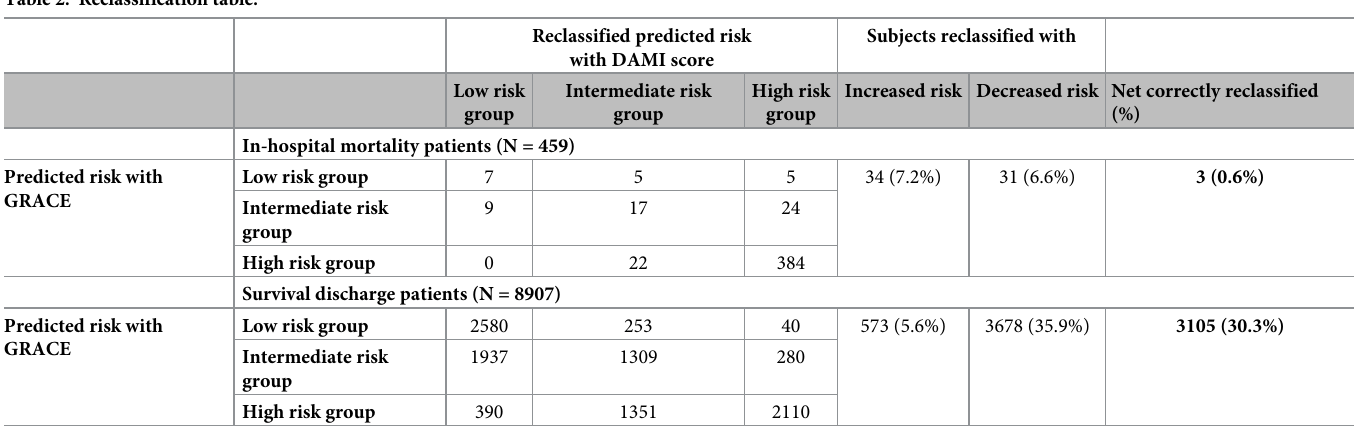
PLOS ONE | https://doi.org/10.1371/journal.pone.0224502 October 31,